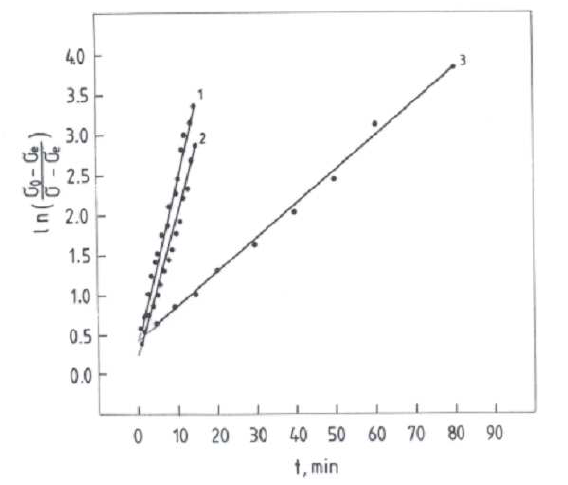
Fig. 4 The logarithmic function versus time, Eq. (7), for the adsorption of dibucaine (curve 1), tetracaine (2), and stearic acid (3) for the same biocompound bulk concentration c 0 of 10 − 3 mole dm − 3